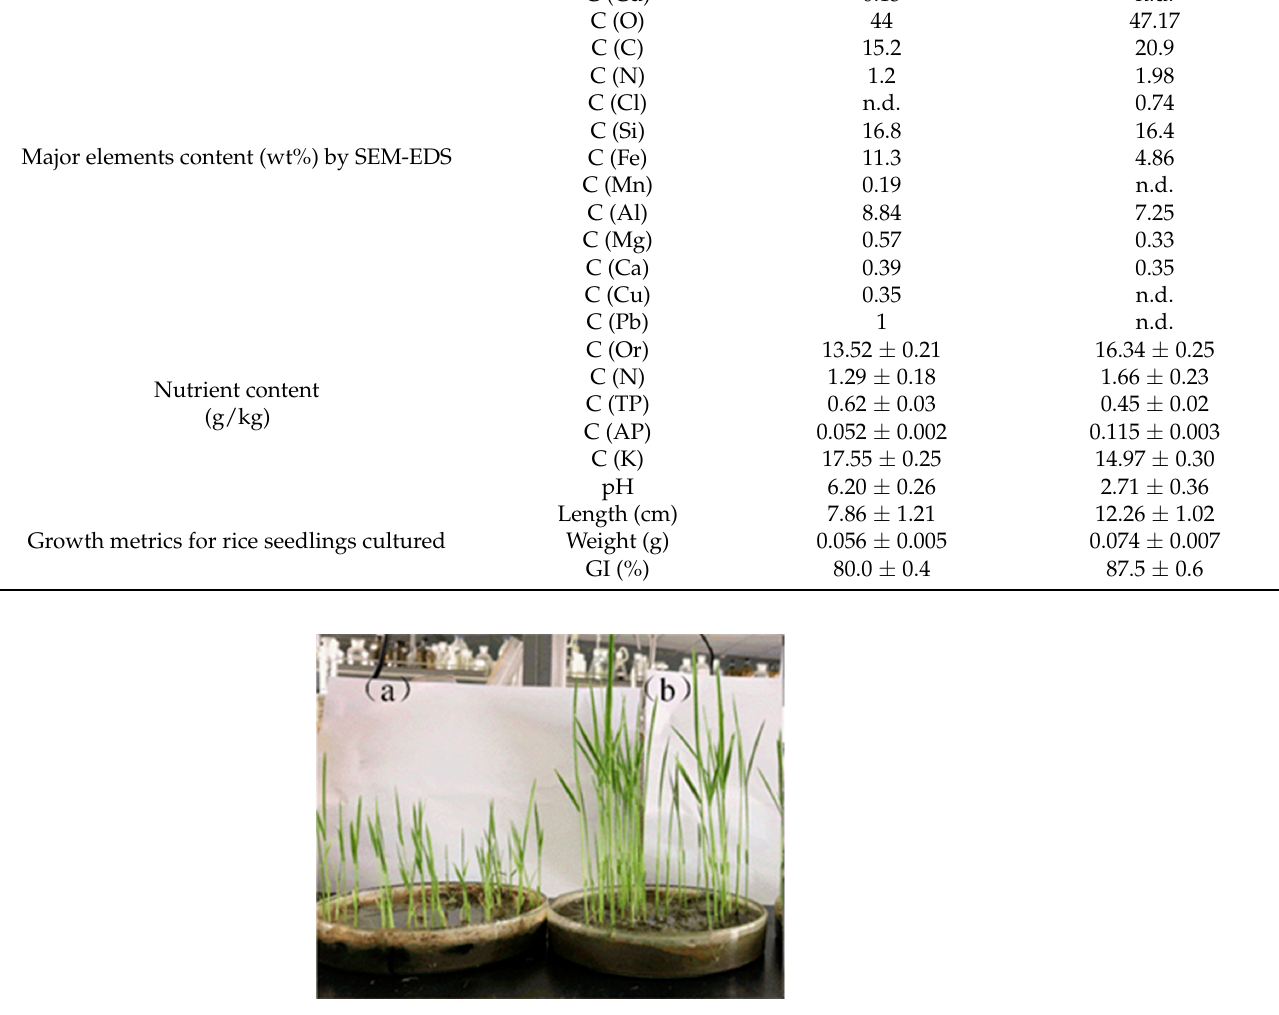
Table 4. Properties of the soil ( a ) before washing; ( b ) after washing with [Gly][Cl].